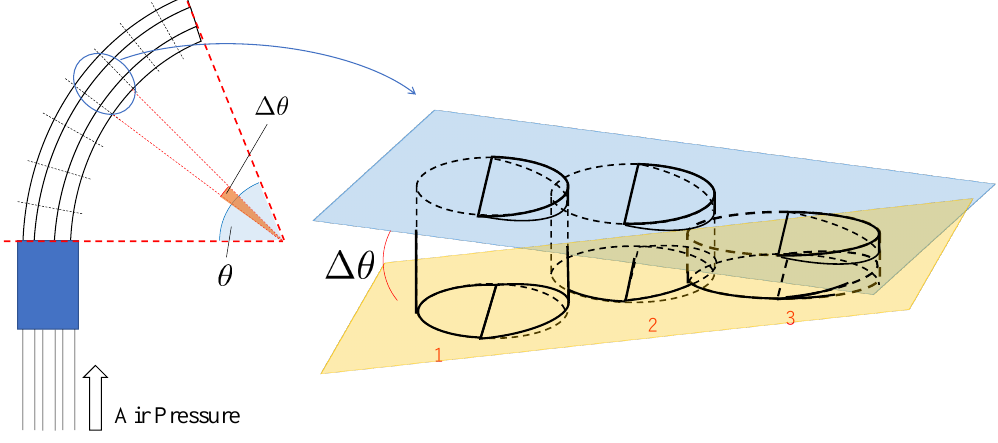
Figure 5. A piece of the divided